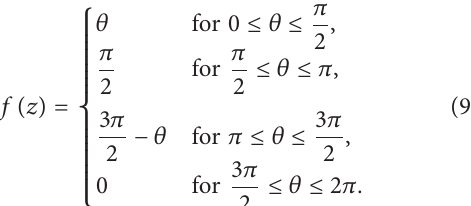
Figure 3: Function satisfying all but continuity criteria for Mostow Monotone and is not Vodopyanov-Goldstein monotone.